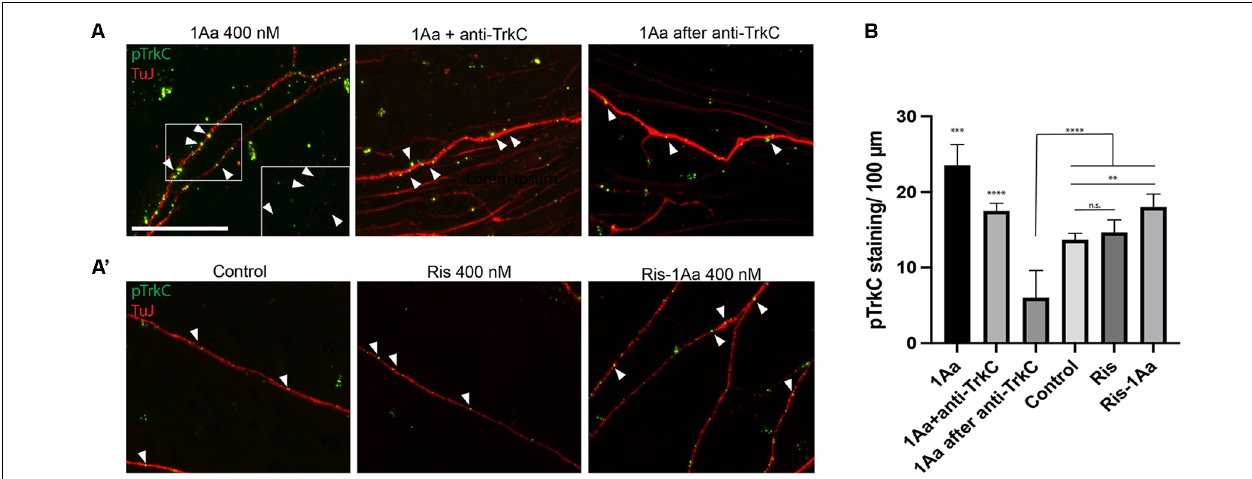
FIGURE 6 | 1Aa and Ris-1Aa activate TrkC in vitro . (A) and (A (cid:48) ) Expression of phosphorylated TrkC (pTrkC) on SGN neurites in vitro . Neurites were stained with neuronal marker TuJ (red), and phosphorylated TrkC (green), and nuclei were labeled with DAPI (blue). Scale bar represents 10 µ m. The outgrowth of 1Aa was compared to pre-treatment with a blocking anti-TrkC antibody (1Aa after anti-TrkC) or simultaneous treatment with 1Aa and anti-TrkC (1Aa + TrkC). (A (cid:48) ) pTrkC staining for control, Ris or Ris-1Aa of the same experiment. Images are one representative experiment of three independently performed experiments. Inlay and arrowheads in (A) and (B) mark examples of pTrkC staining. (B) Quantification of pTrkC per 100 µ m. 1Aa and 1Aa+anti-TrkC were each significant compared to all other conditions ( ∗∗ represents p ≤ 0.01, ∗∗∗ represents p ≤ 0.001, ∗∗∗∗ represents p ≤ 0.0001; n.s., not significant).